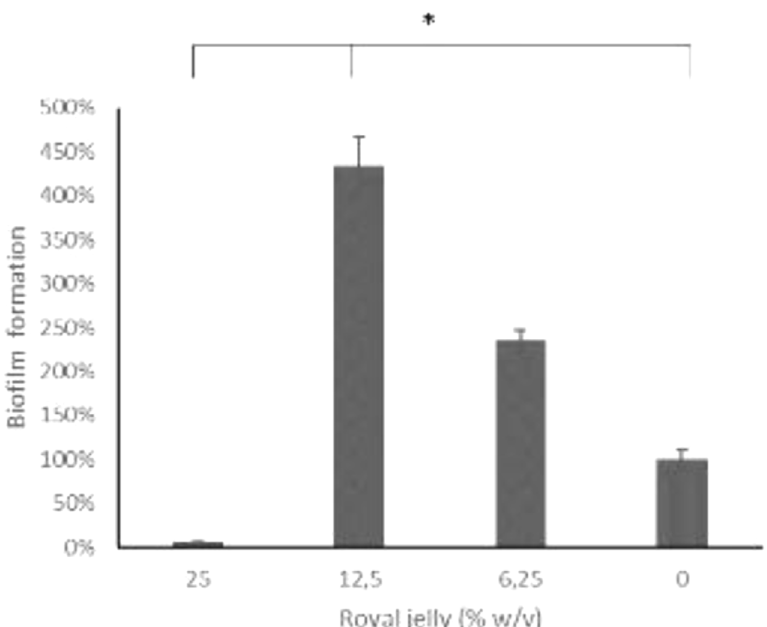
Figure 4. The 12.5% royal jelly increased the formation of P. aeruginosa biofilm stronger than 25% and 6.25% royal jelly. ATCC 10145.